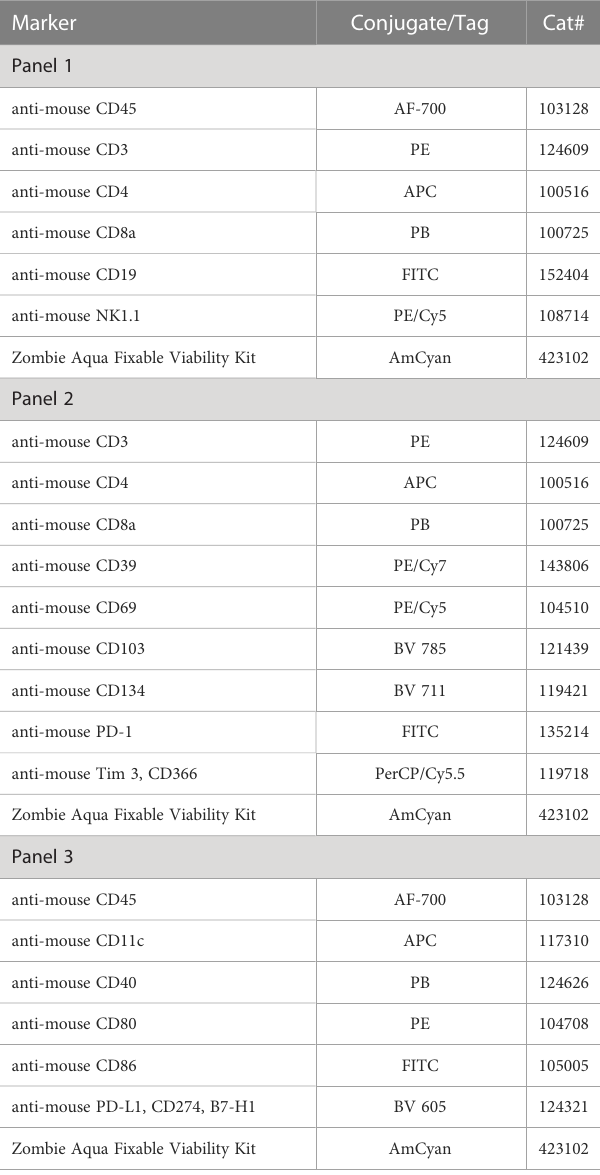
TABLE 1 Antibodies information for fl ow cytometry.